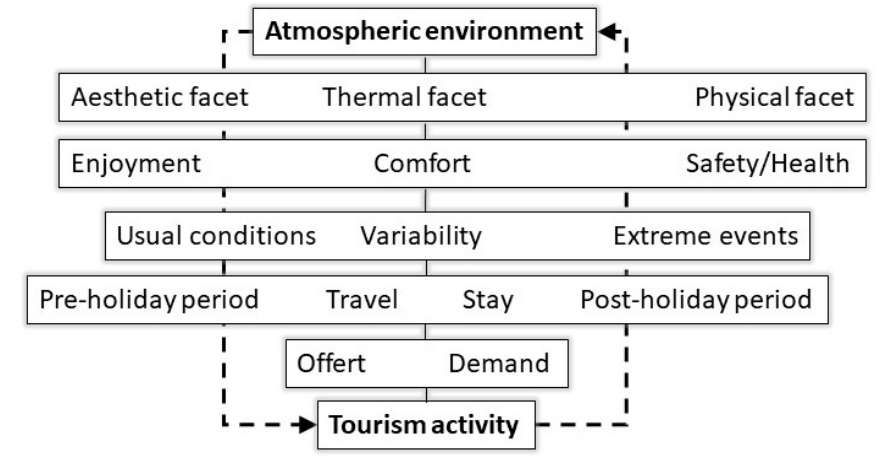
Figure 1. Climate-tourism relationship. Source: [40–44]. Created during this research.